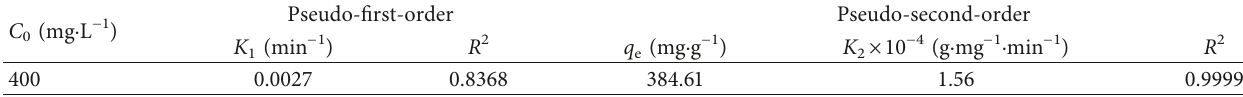
Table 2: Adsorption kinetic parameters of ZIF-8/GO powder.